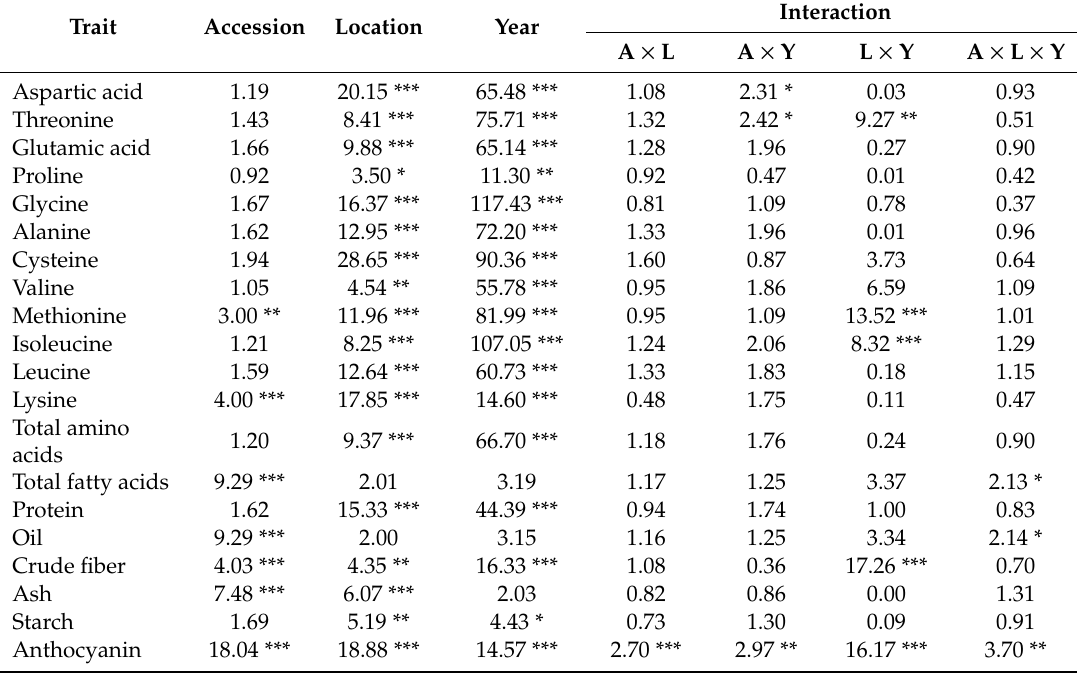
Table 2. Mean squares and ANOVA of grain compositional traits evaluated across locations and years. *, **, *** significant at P < 0.05, 0.01, and 0.001,